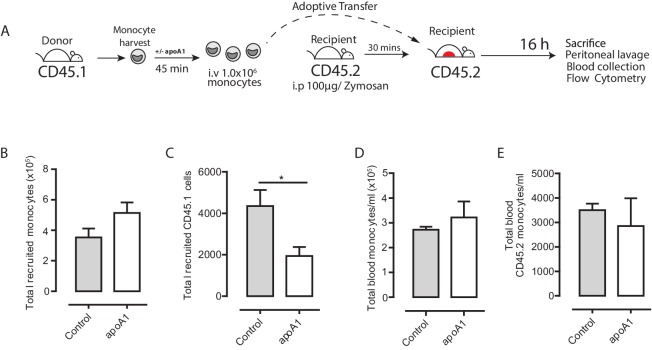
Acute exposure to apoA1 reduces the recruitment of adoptively transferred CD45.1 monocytes to sites of inflammation in CD45.2 recipient mice.(A) Diagram of the experimental design. (B) Monocytes were isolated from SJL/1 mice (CD45.1 positive) bone marrow using ‘no-touch’ negative immunomagnetic selection. Isolated monocytes were characterized as 7/4high/Ly6Glow, with a typical yield of 65–70% monocytes. A total of 1 × 106 isolated CD45.1+ monocytes treated with either apoA1 (40 μg/ml) for 60 min or PBS were adoptively transferred into C57BL/6J mice (CD45.2 positive) by i.v. injection 30 min after i.p. injection with 100 μg zymosan. Mice were euthanized at 16 hr, and peritoneal lavage and blood samples were taken. (B–E) Total monocytes and total adoptively transferred CD45.1+ monocytes were quantified in peritoneal lavage and blood. Data are expressed as mean ± SEM of 8–10 mice from two independent experiments. Statistical analysis was conducted by paired Students T test. **p<0.01, relative to control.